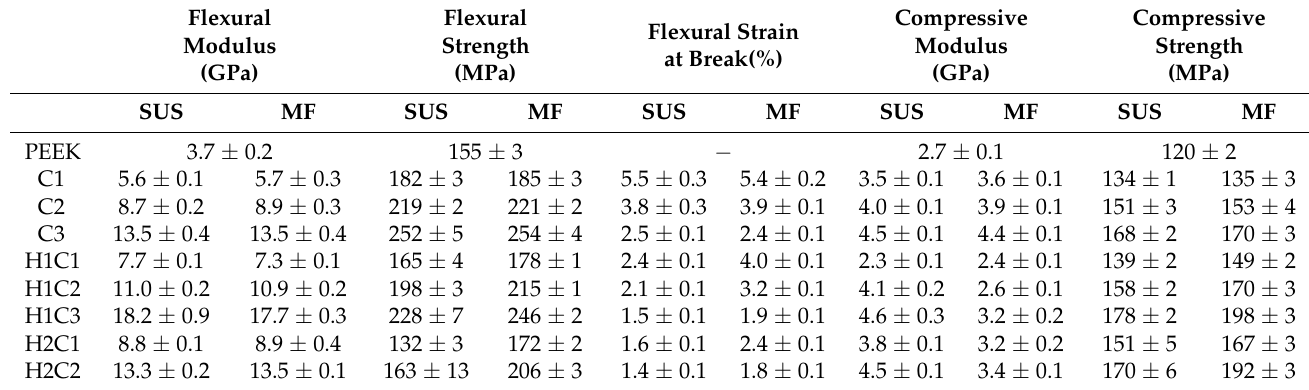
Table 3. Mechanical properties of PEEK